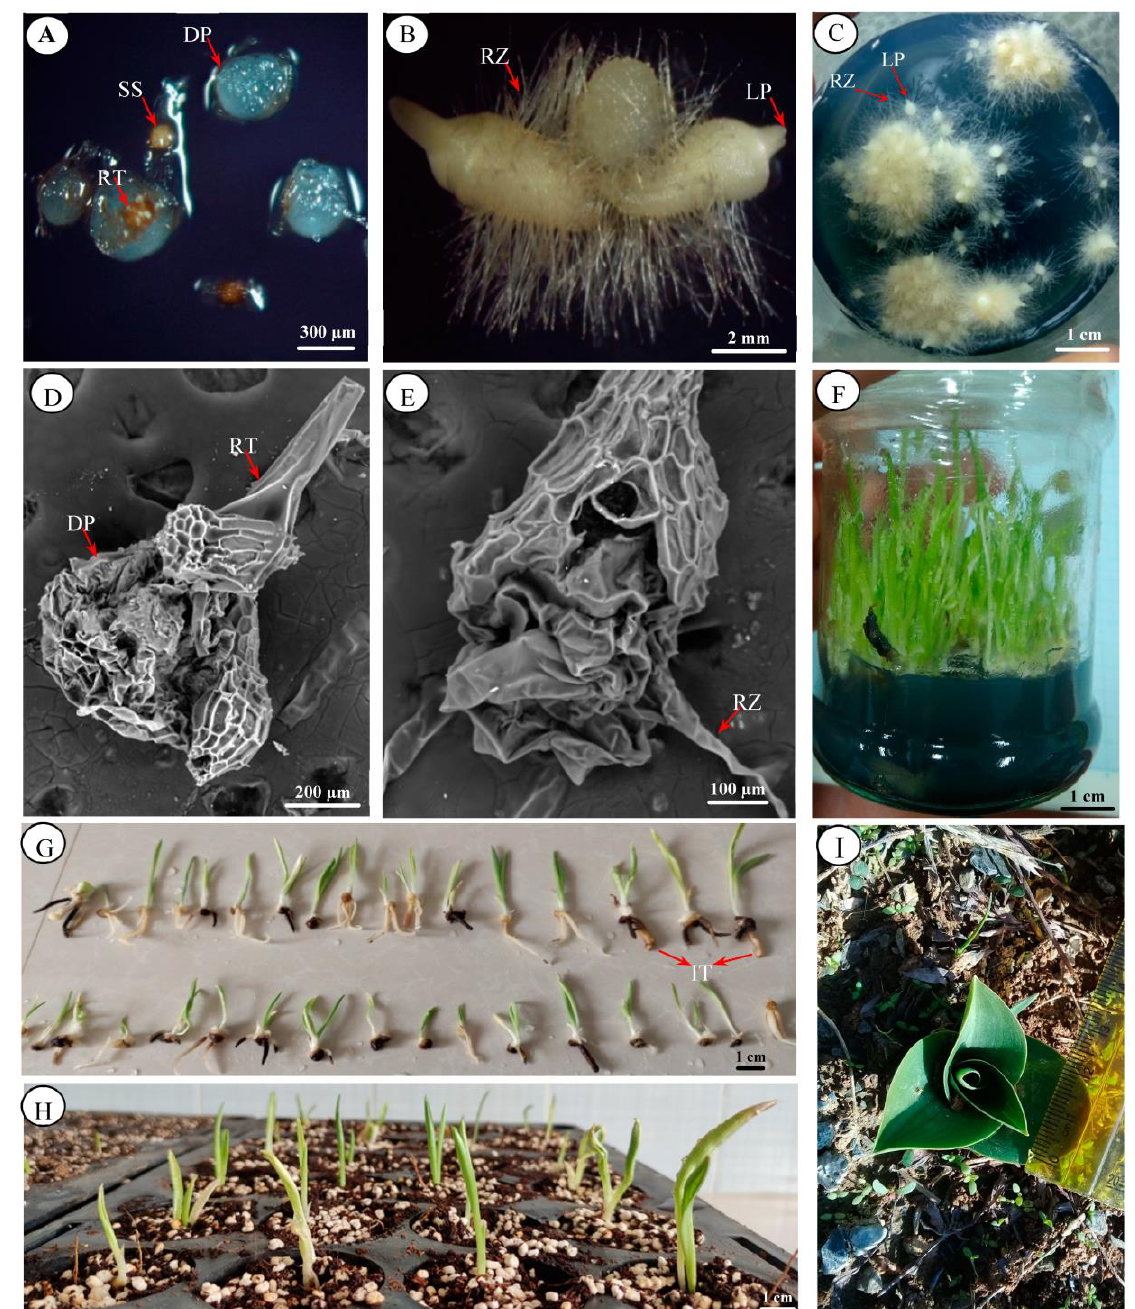
Figure 2. Seed germination and plantlet growth of H. affine (Boiss.) Schltr. ( A ) Embryo enlargement and protocorm formation 16 days after seed sown. ( B , C ) Protocorm development and rhizoid formation 24 – 30 days after seed sown. ( D , E ) SEM micrograph of testa rupturing and asymbiotic seed germination. ( F ) Fully developed plantlets ready for acclimatization 3 – 4 months after seed sown. ( G ) The stages of in vitro protocorm development, rooting, and plantlet growth. ( H ) In vitro-raised plantlets successfully acclimatized and transferred to plugs. ( I ) H. affine plant established under field condition in the next spring. SS, swelling seed; RT, rupturing testa; DP, developing protocorm-like bodies (PLBs); RZ, rhizoids; LP, leaf primordium; IT, in vitro formed tubers.